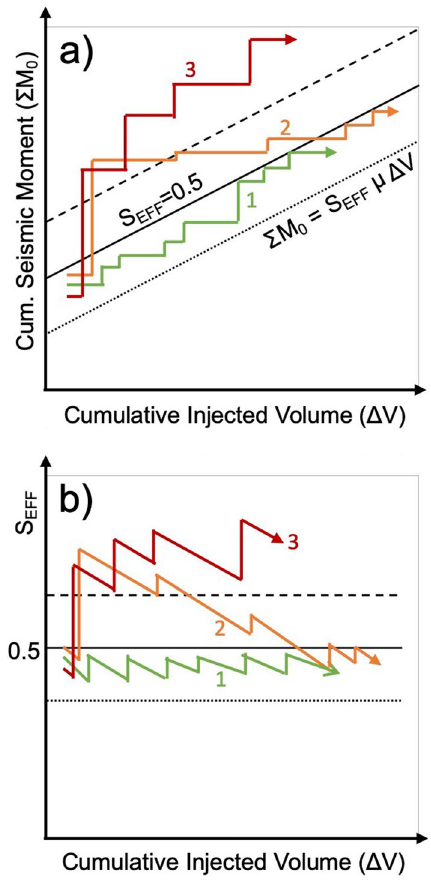
Figure 3. Schematic illustrations of conceptual induced seismicity response paths. In ( a ) we show the potential evolution of ΣM 0 relative to ΔV for three conceptual scenarios. Scenario 1 (in green) shows an arrested-rupture case, where magnitudes are always limited by the injection volume according to Eq. (3), with S EFF = 0.5. Scenario 2 (orange) shows a runaway rupture case, where ΣM 0 exceeds this cap given by Eq. (3). However, over time, once the tectonic strain energy budget has been released the cumulative seismic moment relationship reverts to that described by Eq. 3. Scenario 3 (red) shows a runaway rupture case where the tectonic strain energy continues to contribute to the induced seismicity over an extended period, with ΣM 0 continuing to exceed the Eq. (3) cap. In ( b ) we show the same conceptual scenario paths viewed with respect to S EFF